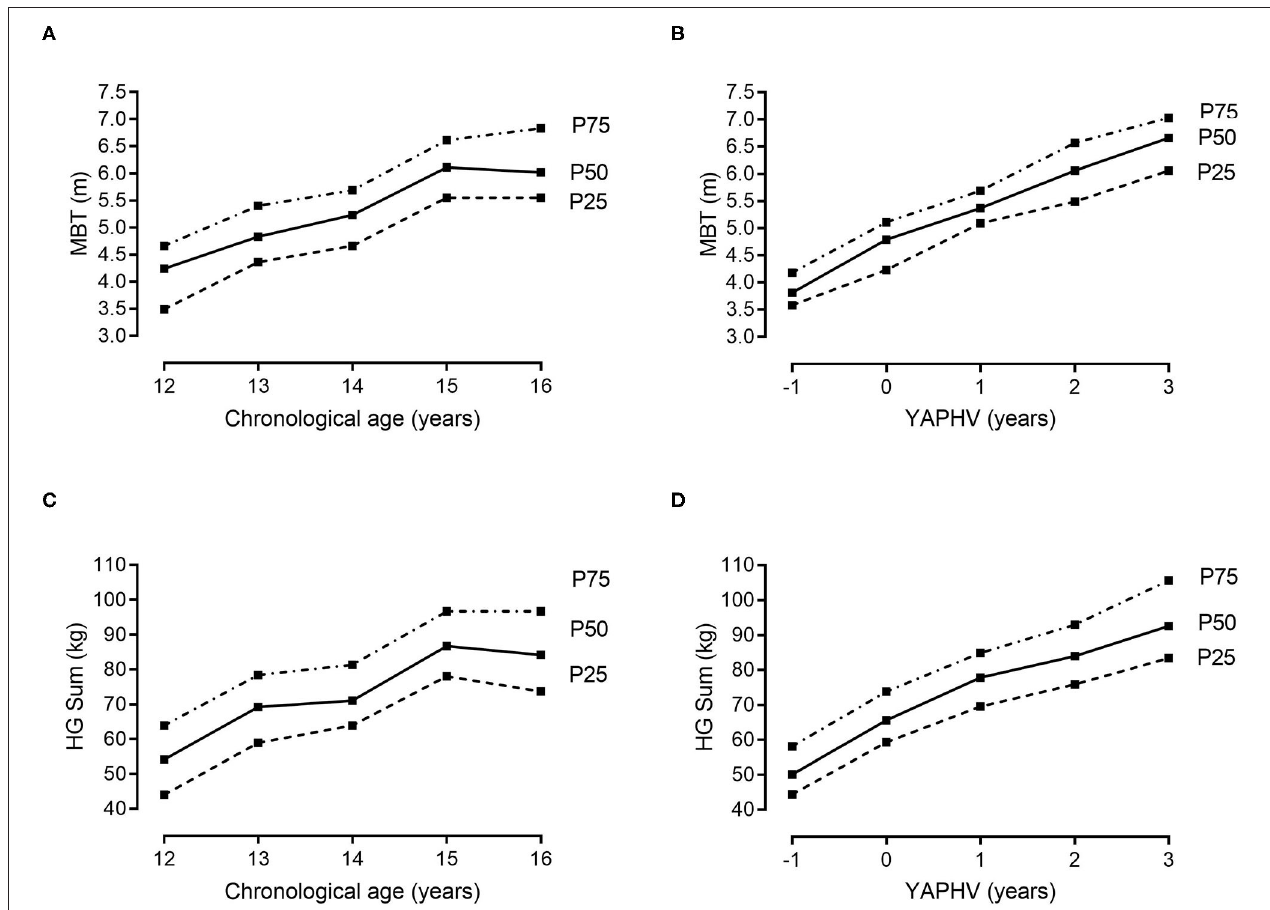
FIGURE 2 | References values (10th, 25th, 50th, 75th and 90th percentiles) for speed and agility of young Portuguese male basketball players, according to their chronological age and maturity status.